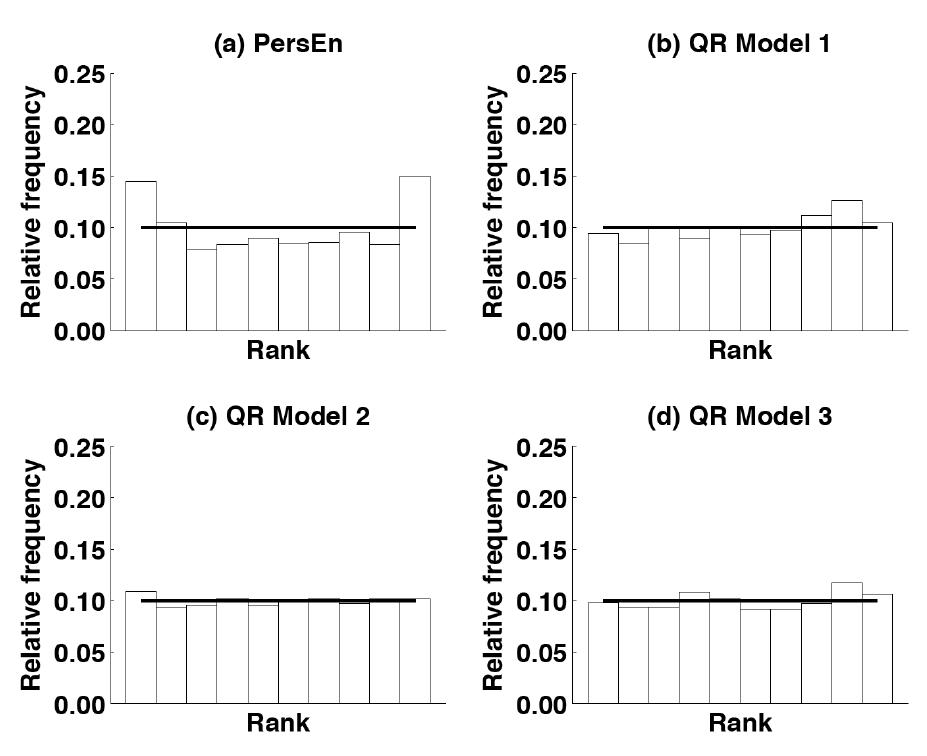
Figure 4. Rank histograms for the site of Le Tampon. ( a ) PersEns Model; ( b ) QR Model 1; ( c ) QR Model 2; ( d ) QR Model 3. The black horizontal line represents the theoretical relative frequency (here 1 11